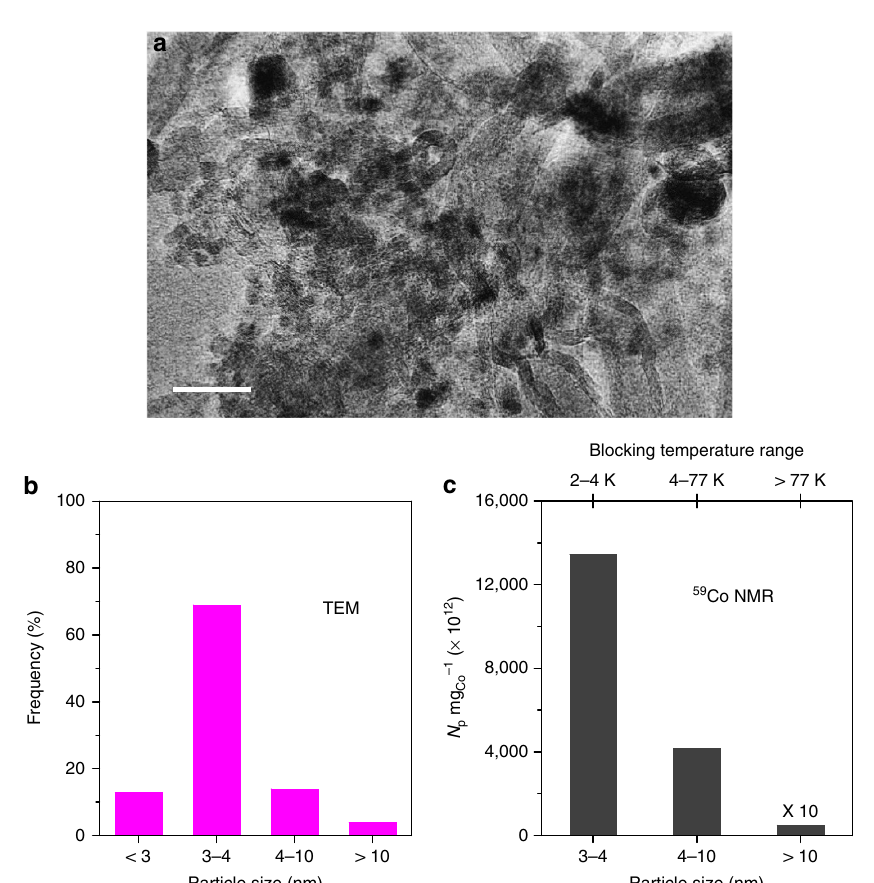
Figure 2 | TEM and TDFNR cobalt particle size analyses. ( a ) TEM micrograph of CoCNTA sample (scale bar, 20nm). ( b ) Corresponding cobalt particle size distribution, which is calculated from hundreds of Co particles based on the statistical TEM measurements. ( c ) Cobalt particles numbers per mg of cobalt ( N p mg Co (cid:2) 1 ) in the different particles size ranges as a function of the blocking temperature measured by TDFNR. The number of size ranges is limited to 3 because the smallest particles ( o 3nm) observed by TEM cannot be measured at the lowest FNR temperature. The discrepancy observed for the large Co particles ( 4 10nm) between the TEM and FNR techniques could be attributed to the extremely small area of investigation. The total catalyst weight analysed by FNR is B 100mg while that analysed by TEM is less than a